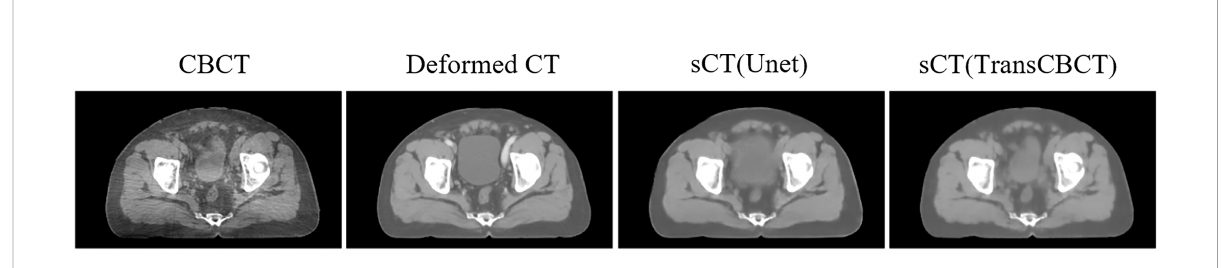
FIGURE 6 Result of a pure convolution-based Unet that made the shape of the bladder vary from CBCT. TransCBCT and Unet employed the same U- shape structure and loss function. However, with transformer block embedded, TransCBCT showed the ability to keep the raw CBCT